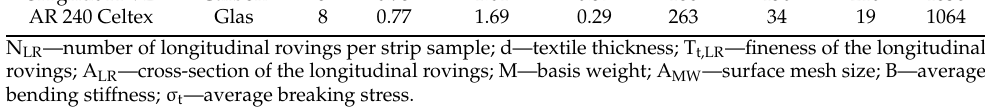
Table 2. Overview of the material characteristics of the examined textiles. Textile